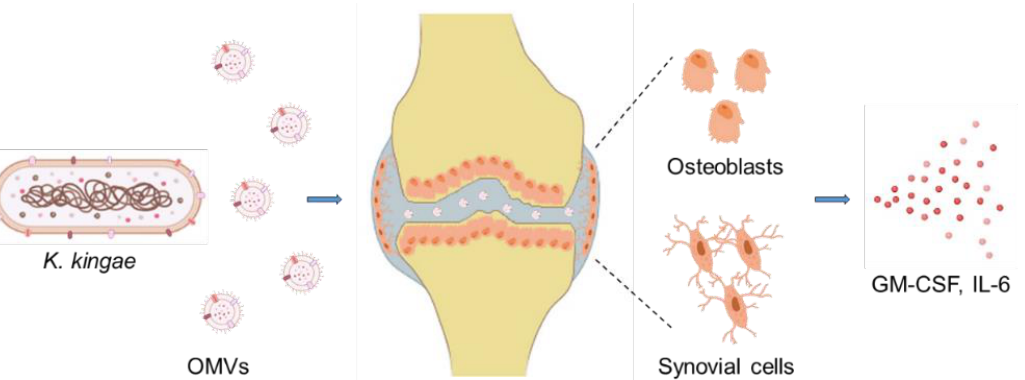
Figure 8. The proposed mechanism of action of K. kingae strain PYKK081 OMVs in human bone. OMVs released by K. kingae are internalized by human osteoblasts and synovial cells. This leads to increased production of two cytokines, GM-CSF and IL-6, which might be involved in the signaling response of infected bone and joint tissues during K. kingae infection. This image was created using BioRender.com.